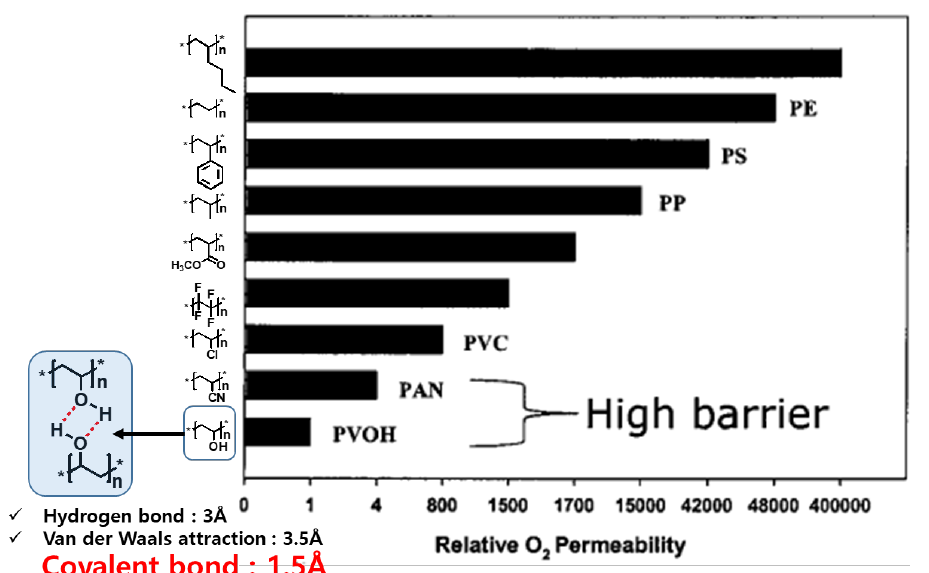
ff ect for O 2 barrier property in polymeric materials